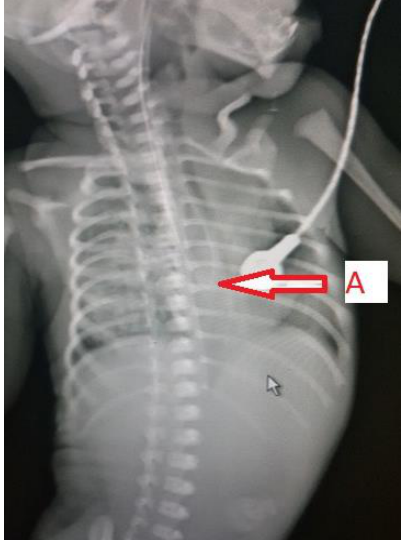
Figure 1: The X-ray with nasogastric tube in situ showing the level of upper pouch at the level of T7–T8 vertebrae (A) and gasless